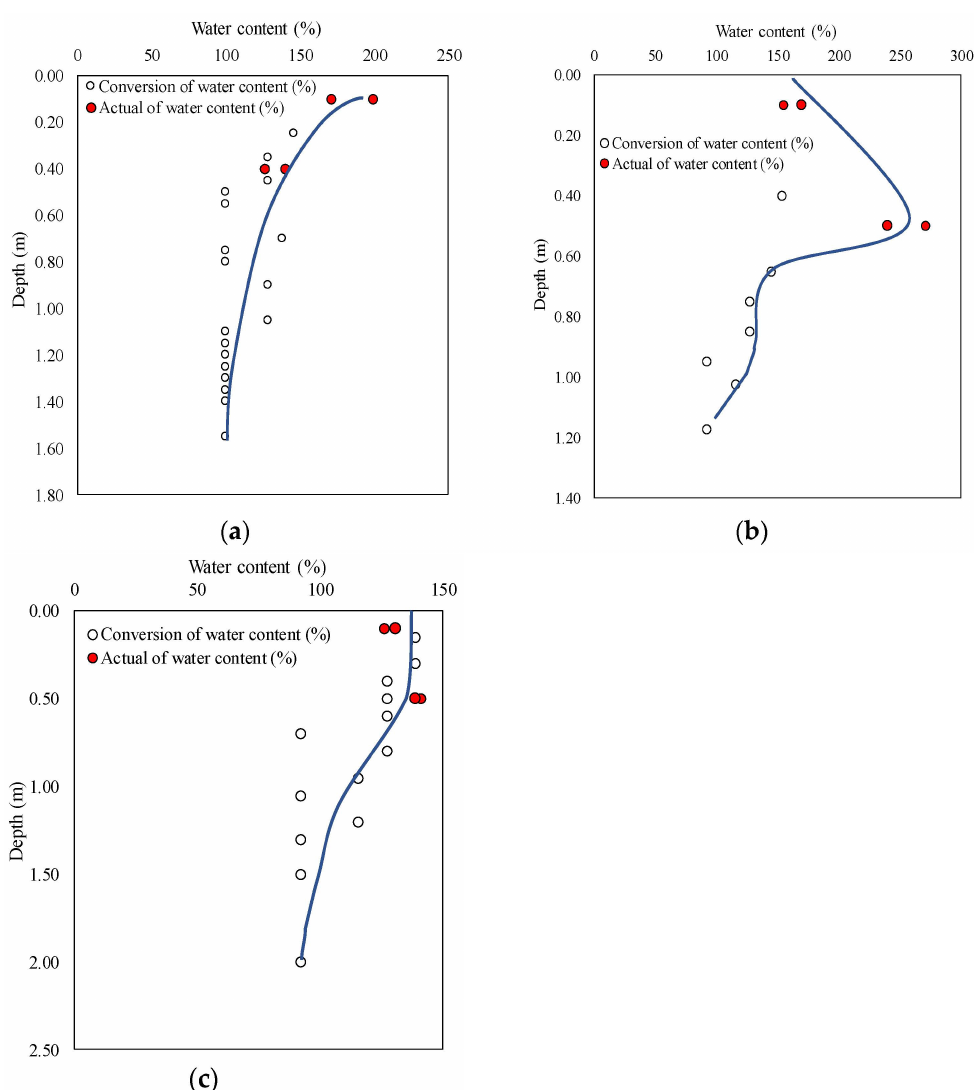
Figure 5. Change in water content based on depth in areas № 1–3. ( a ) area № 1, ( b ) area № 2, ( c ) area №